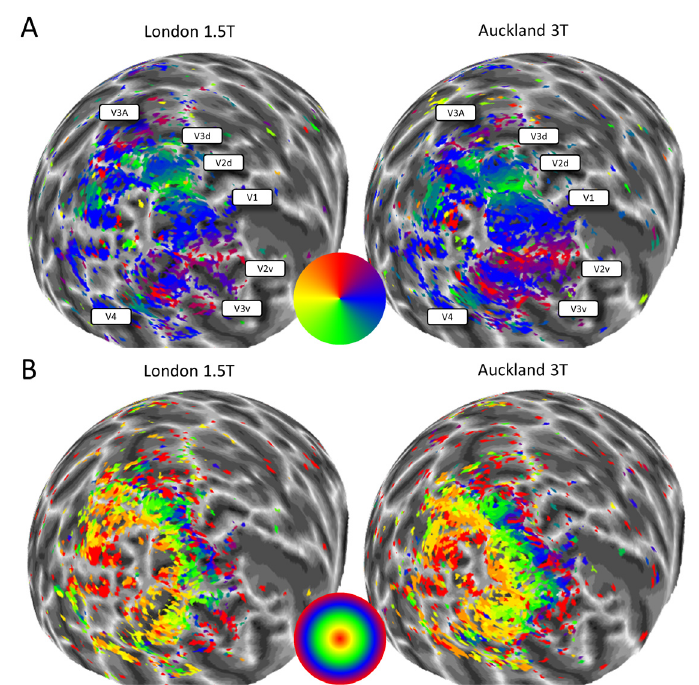
Figure 2. Polar angle ( A ) and eccentricity ( B ) maps of one participant from the London 1.5T site (left) and the Auckland 3T site (right) displayed on a spherical model of the left hemisphere. Colour wheels denote the pseudo-colour code for visual field maps. No smoothing or interpolation was applied to the mapping data. Voxels were thresholded at R 2 >0.1. In A, the position of the visual regions have been labelled for reference. The greyscale indicates the cortical folding